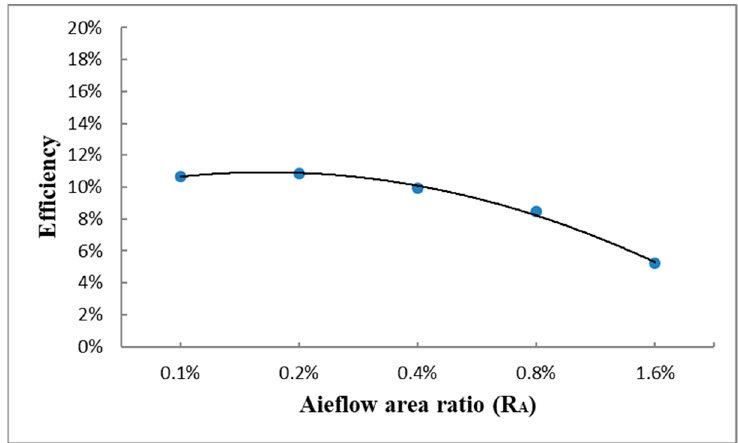
Figure 13. Efficiency corresponding to area ratio of orifice cross-section.